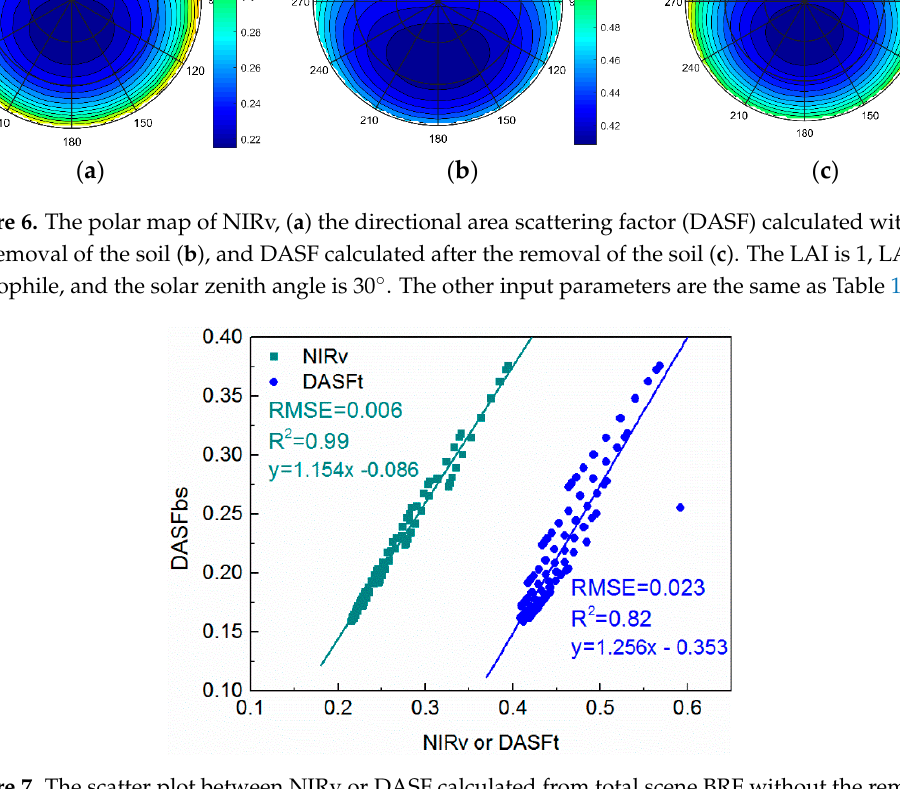
Figure 7. The scatter plot between NIRv or DASF calculated from total scene BRF without the removal of the soil (DASF t ), with DASF calculated at the black soil condition (DASF bs ). The LAI is 1, and the solar zenith angle is 30°. The other input parameters are the same as Table 1 or Figure 5.